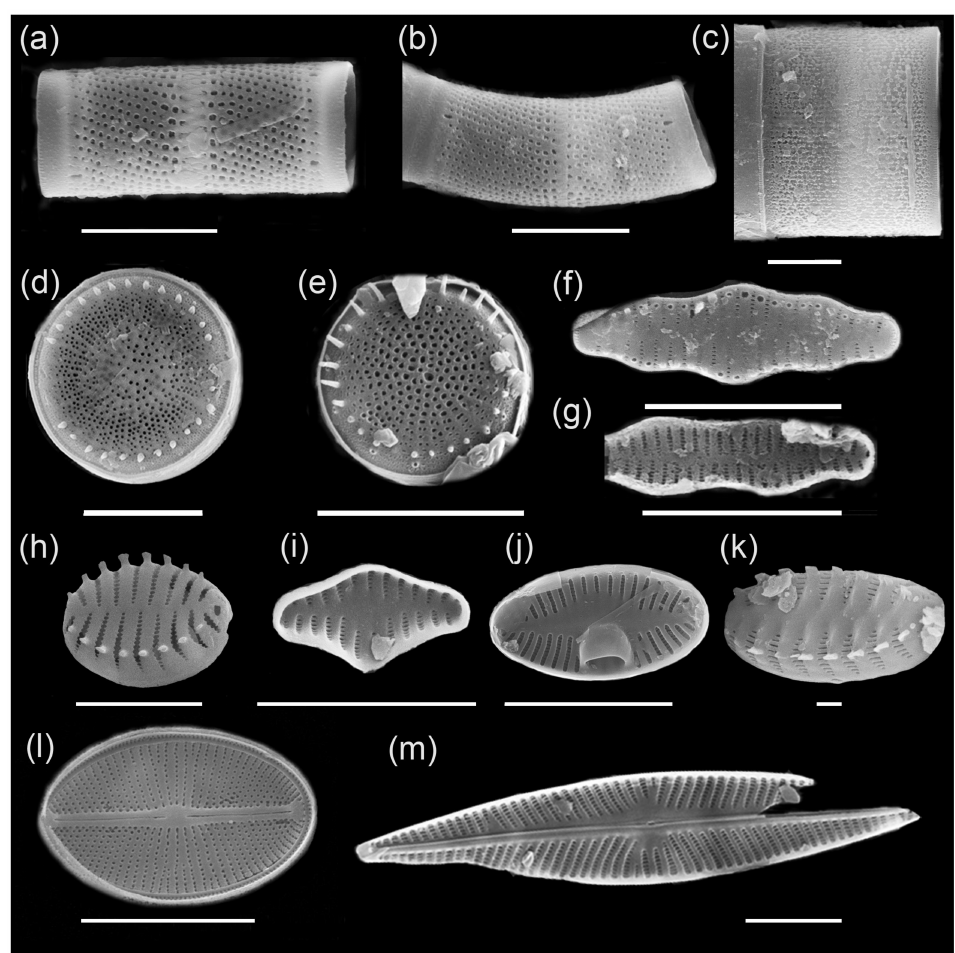
Figure 5. Main complex of diatoms of Ecozone I: ( a ) Aulacoseira ambigua, ( b ) A. ambigua f. curvata, ( c ) Melosira undulata, ( d ) Stephanodiscus tuncaensis, ( e ) Stephanodiscus sp., ( f ) Staurosira construens var. triundulata, ( g ) Staurosira binodis, ( h ) Staurosira venter, ( i ) Staurosira construens, ( j ) Planotidium joursacense, ( k ) Staurosirella pinnata, ( l ) Cavinula cocconeiformis, ( m ) Navicula radiosa. Scale bars: 10 µ m ( a – j , l , m ) and 1 µ m ( k